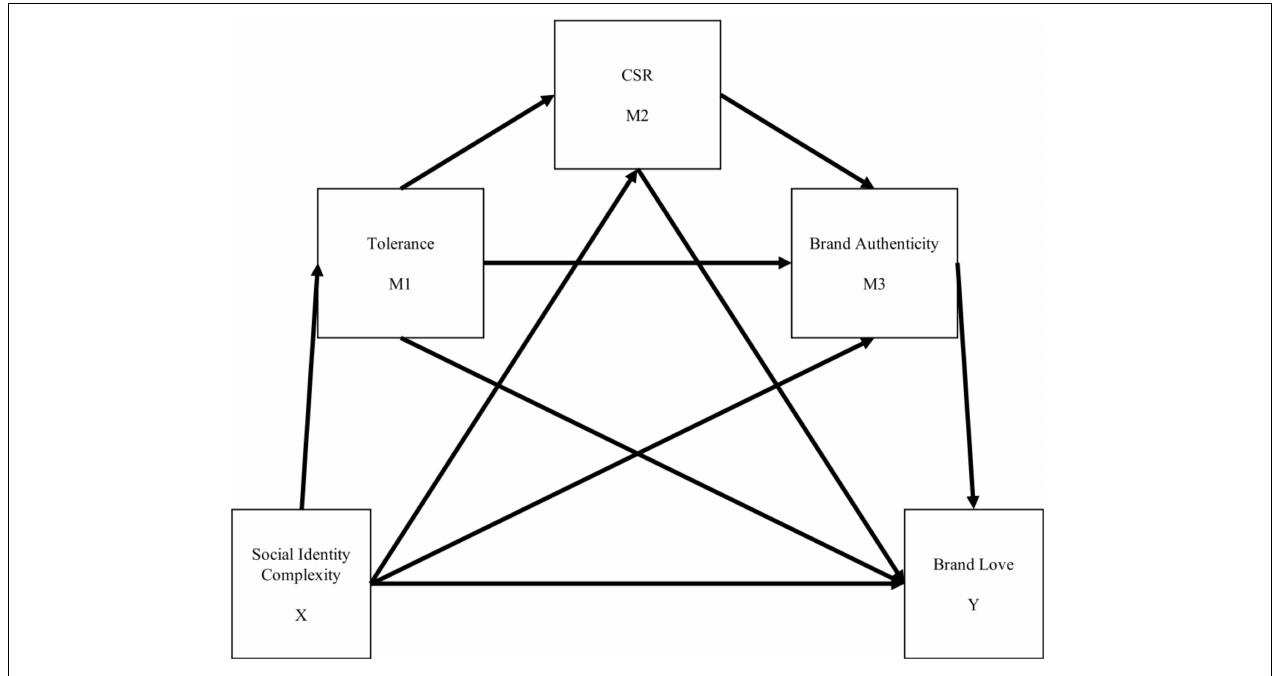
FIGURE 1 | Conceptual model for this